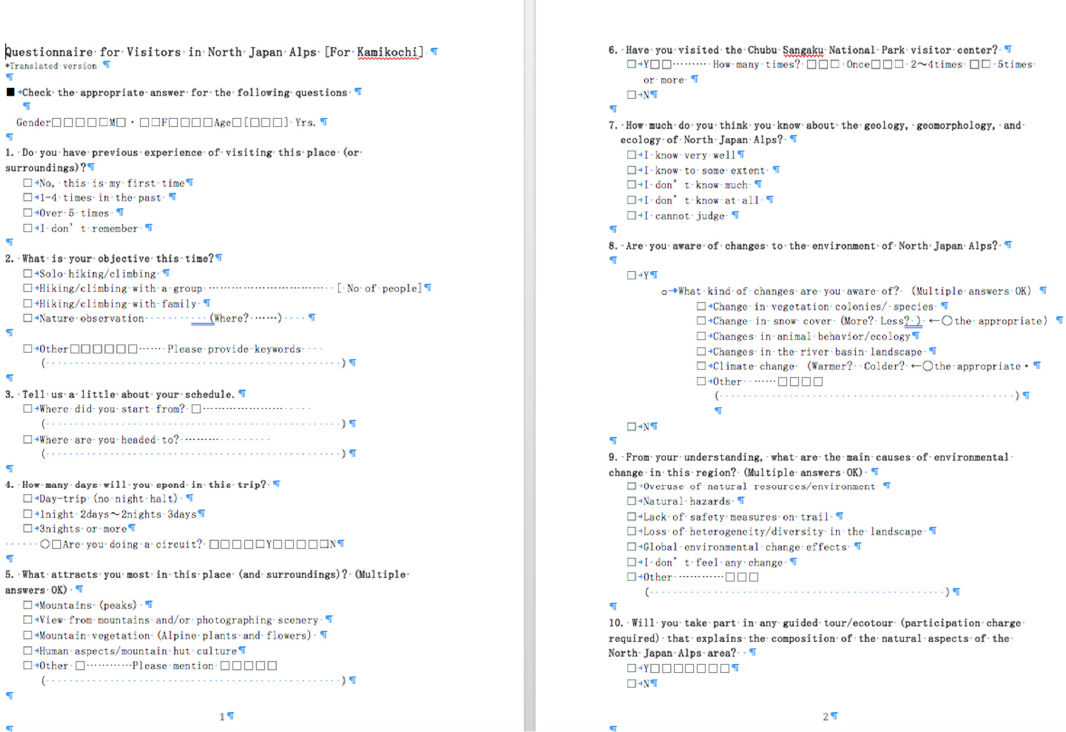
Figure A1. Questionnaire used in the study (Translated version).